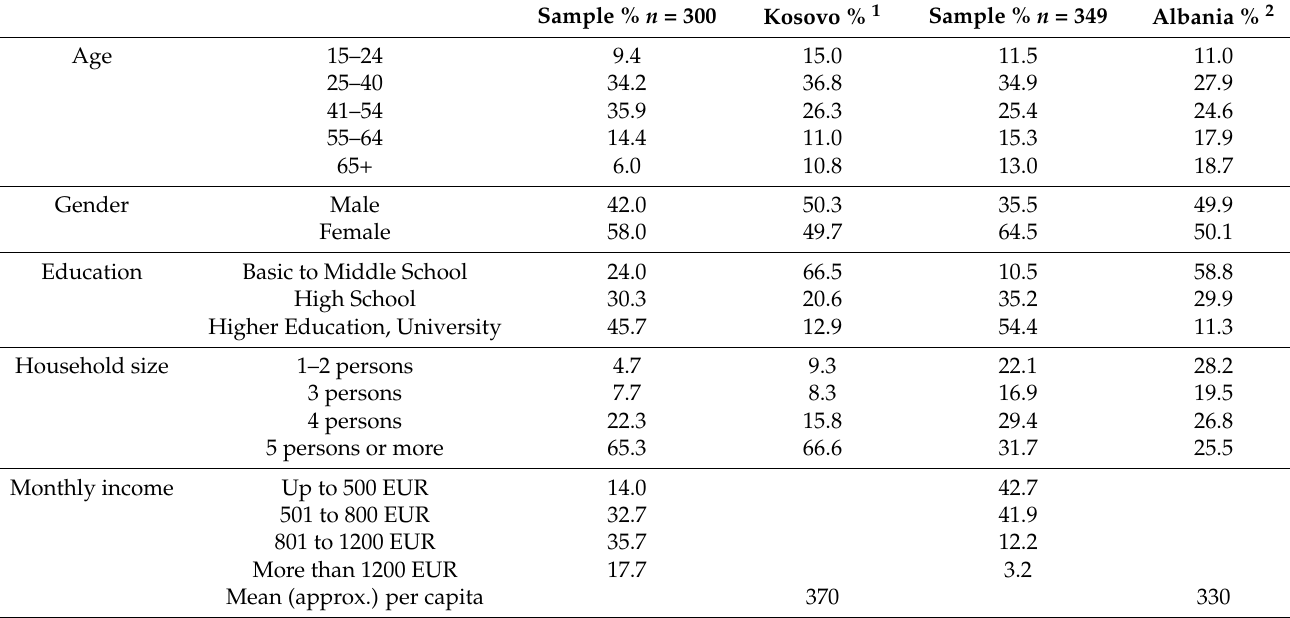
Table 1. Socio-demographic variables of the sample and